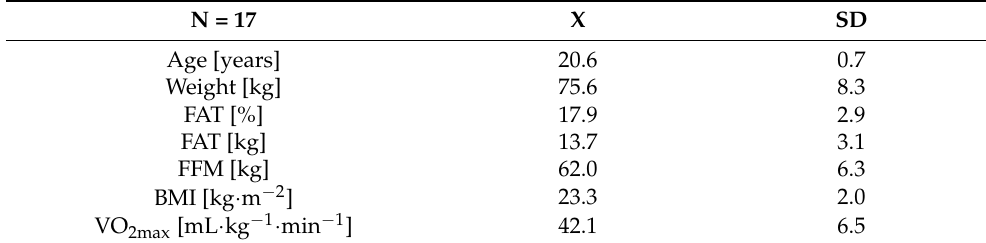
Table 1. Participants